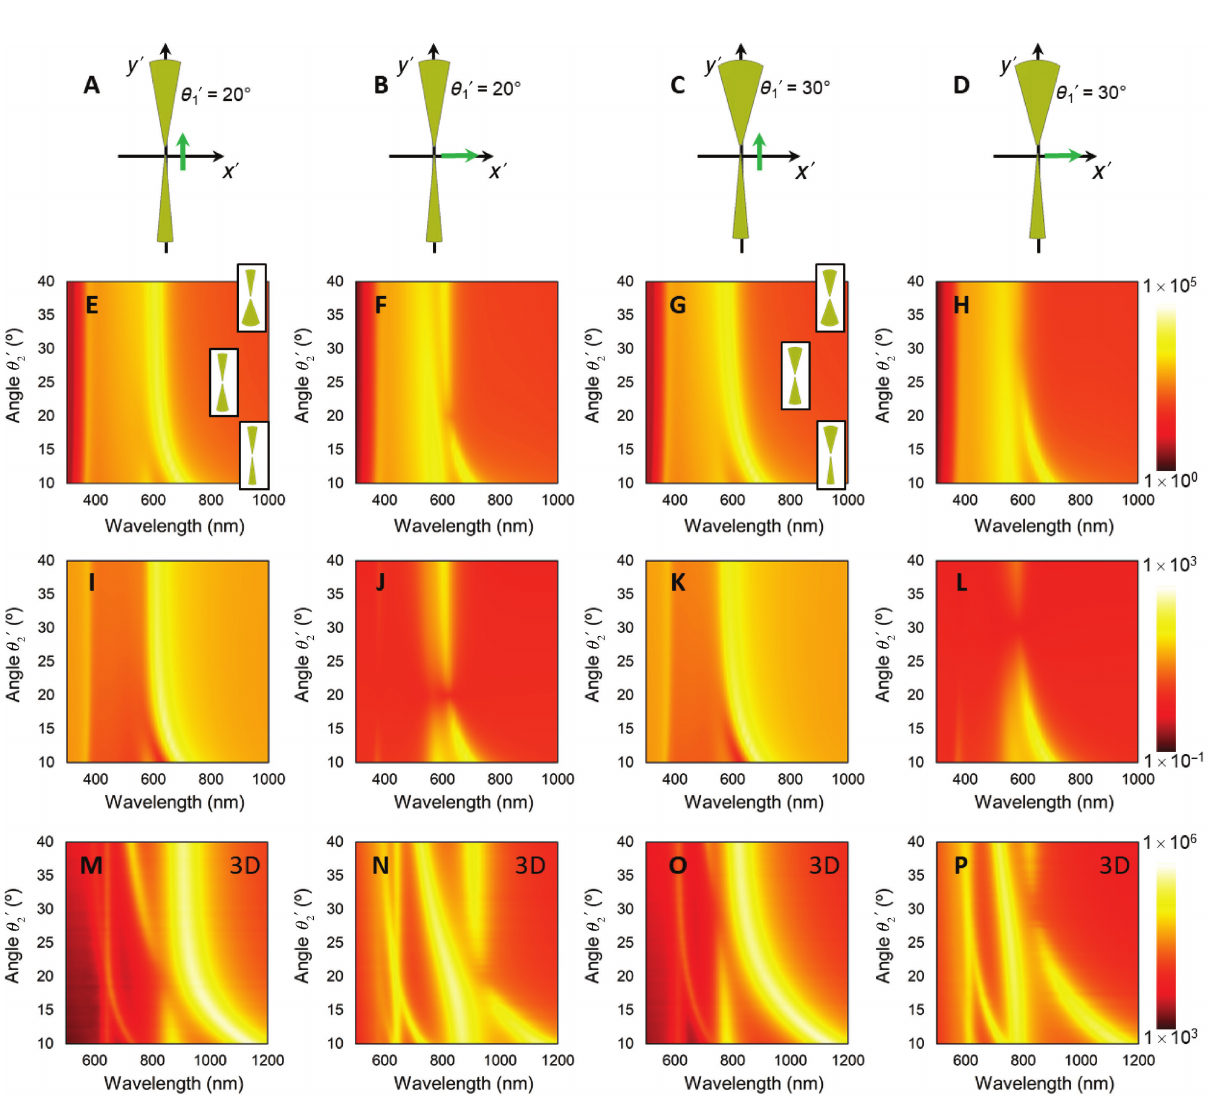
20 (A, B) and θ ′ °= 30 (C, D) illuminated by a vertical 1 1 (second row) and Γ (third nr r 2